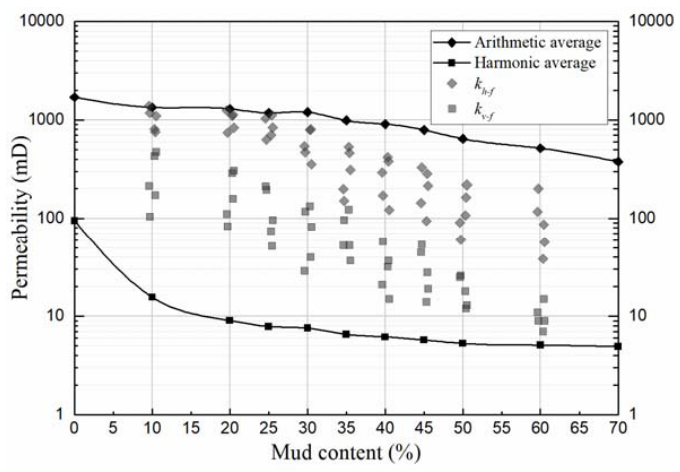
Figure 14. Permeability calculation results of each realization at the full model size (for ISWZs with varying width-100 m).